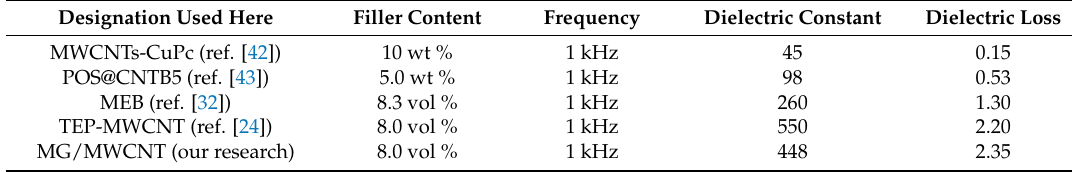
Table 1. Dielectric parameters for our research compared with the corresponding